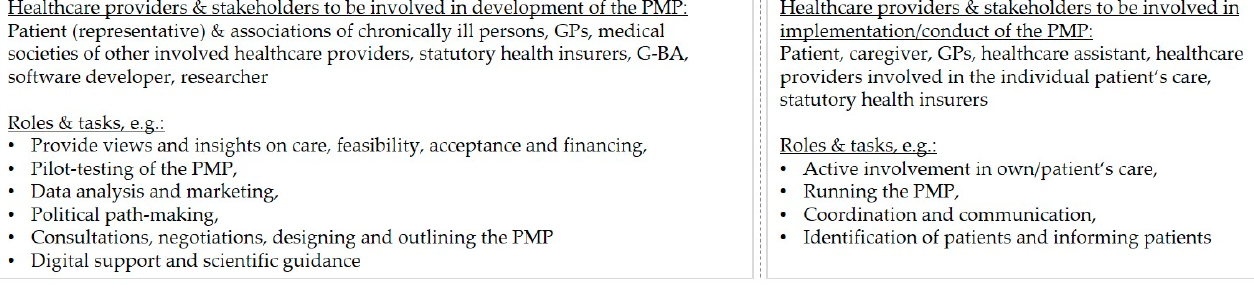
Figure 1. Overview of key issues. Abbreviations: ADE—adverse drug event, ADR—adverse drug reaction, CDSS—clinical decision support system, G-BA—Federal Joint Committee, GP—general practitioner, MM—multimorbidity, PMP—polypharmacy management program, PP—polyphar- macy.